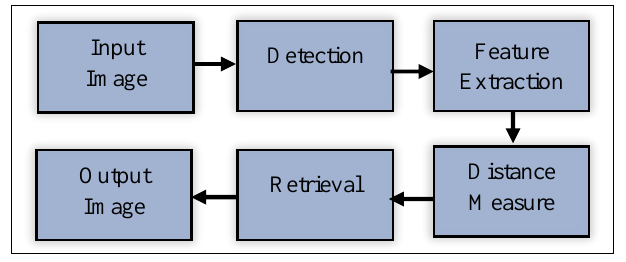
Fig. 1 . Basic flow of proposed